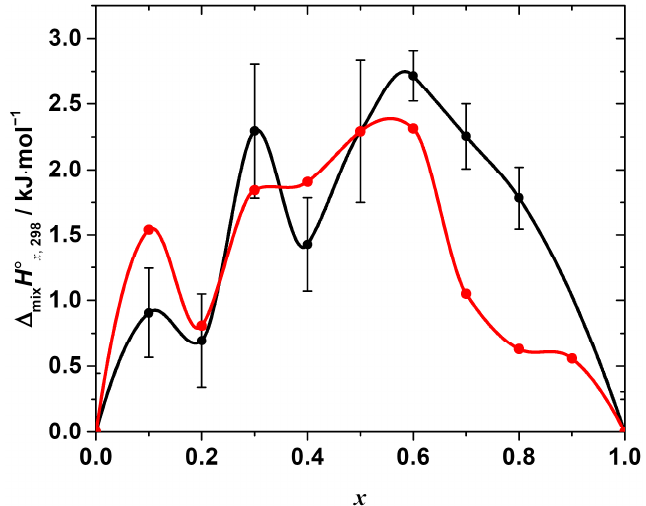
Figure 5. Standard mixing enthalpy of the solid solutions CH 3 NH 3 Pb(Cl 1 − x Br x ) 3 determined by calorimetry (black points) in comparison with the one calculated from the results of molecular dynamics simulation (red points). All the dependences are interpolated by Akima splines.